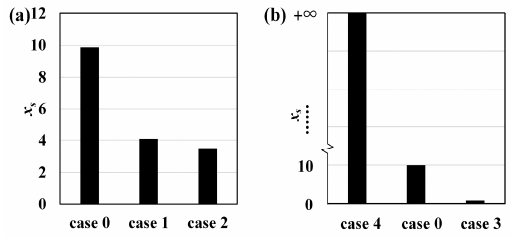
Figure 16. Comparison of results between different cases: ( a ), case 0, case 1 and case 2 with different lateral pressure coefficient, ( b ) case 4, case 0 and case 3 with different lithology. Table 2. Results of the support installation.